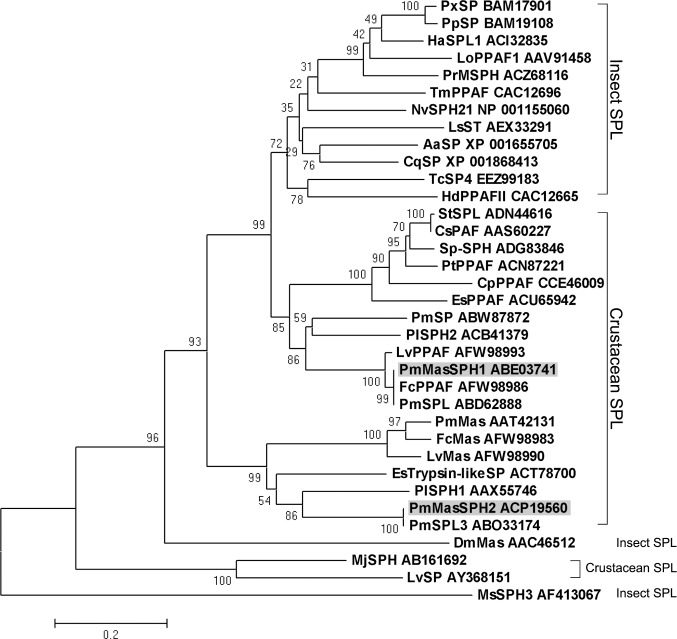
The phylogenetic relationship between serine proteinase domains from PmMasSPH1 and PmMasSPH2 and other serine proteinases.The deduced amino acid sequences of SP-domains from various clip-SPH species were used to generate a phylogenetic tree by the neighbor-joining method. Percent bootstrap values (1000 replicates) are shown at each branch point. PmMasSPH1 (ABE03741); PmMasSPH2 (ACP19560); PmSP, P. monodon serine proteinase (ABW87872); PmSPL, P. monodon serine proteinase-like protein (ABD62888); PmSPL3 (ABO33174); PmMas, P. monodon mas-like protein (AAT42131); FcPPAF, Fenneropenaeus chinensis prophenoloxidase activating factor (AFW98986); FcMas (AFW98983); LvPPAF, Litopenaeus vannamei PPAF (AFW98993); LvSP (AY368151); LvMas (AFW98990); PlSPH1, P. leniusculus SPH1 (AAX55746); PlSPH2 (ACB41379); MsSPH3, Manduca sexta SPH3 (AF413067); HdPPAFII, Holotrichia diomphalia PPAFII (CAC12665); MjSPH, Marsupenaeus japonicus SPH (AB161692); NvSPH21, Nasonia vitripennis SPH21 (NP_001155060); CqSP, Culexquin quefasciatus SP (XP_001868413); AaSP, Aedes aegypti SP (XP_001655705); PtPPAF, Portunus trituberculatus PPAF (ACN87221); CsPAF, Callinectes sapidus PAF (AAS60227); EsPPAF, Eriocheir sinensis PPAF (ACU65942); EsTrypsin-likeSP (ACT78700); LsST, Lucilia sericata salivary trypsin (AEX33291); CpPPAF, Cancer pagurus PPAF (CCE46009); PpSP, Papilio polytes SP(BAM19108); HaSPL1, Helicoverpa armigera SPL1 (ACI32835); TmPPAF, Tenebrio molitor PPAF (CAC12696); StSPL, Scylla tranquebarica SPL (ADN44616); LoPPAF1, Lonomia obliqua PPAF1 (AAV91458); PxSP, Papilio xuthus SP (BAM17901); PrMSPH, Pieris rapae MSPH (ACZ68116); TcSP4, Tribolium castaneum SP4 (EEZ99183); DmMas, Drosophila melanogaster Mas (AAC46512); Sp-SPH, S. paramamosain SPH (ADG83846).